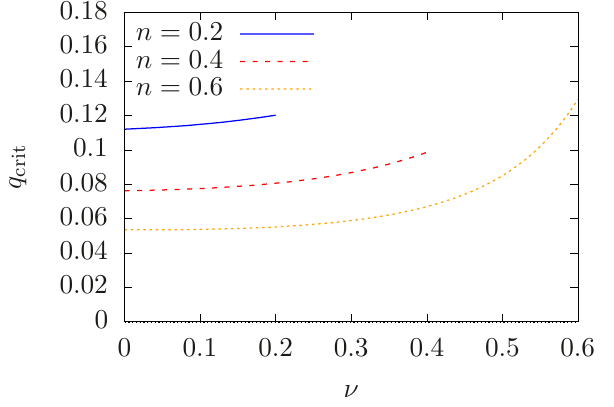
Figure 4 . Plots of q crit against (cid:23) for various n . Note that the allowed ranges of (cid:23) are (cid:23) hence each curve terminates at their respective (cid:23) = n